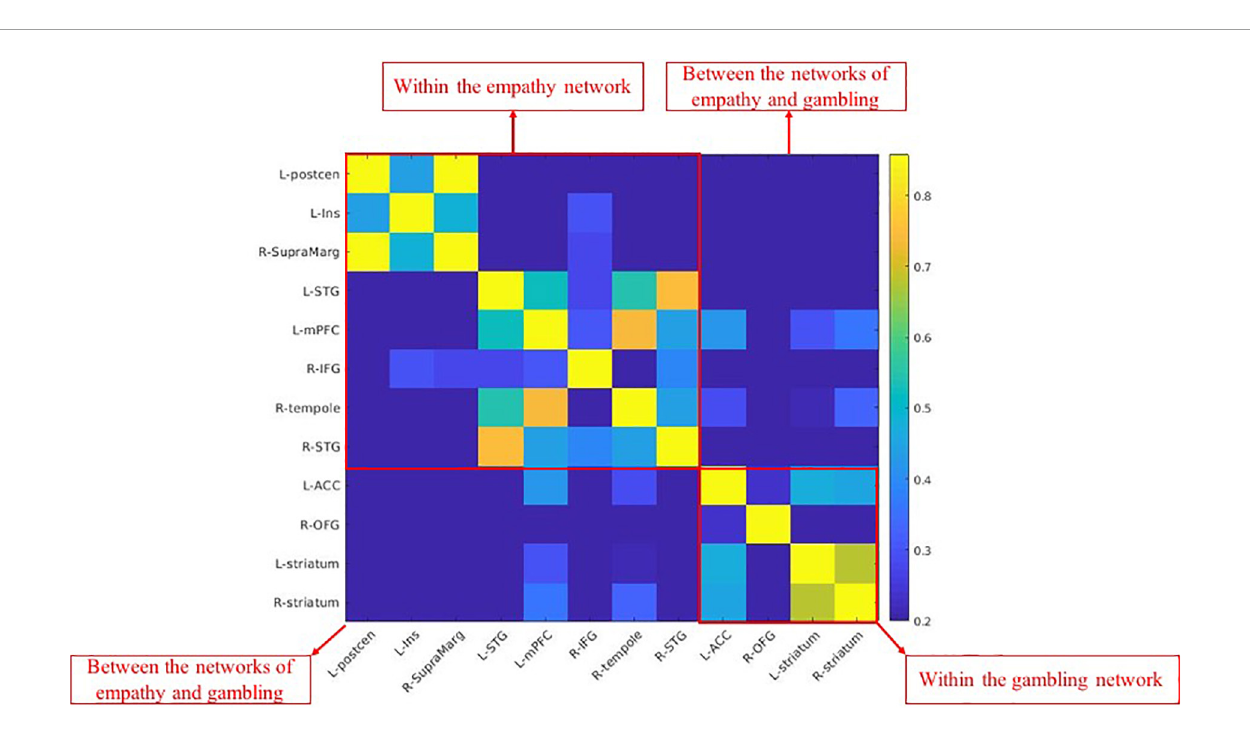
FIGURE2 The functional connectivity matrix of empathy and gambling